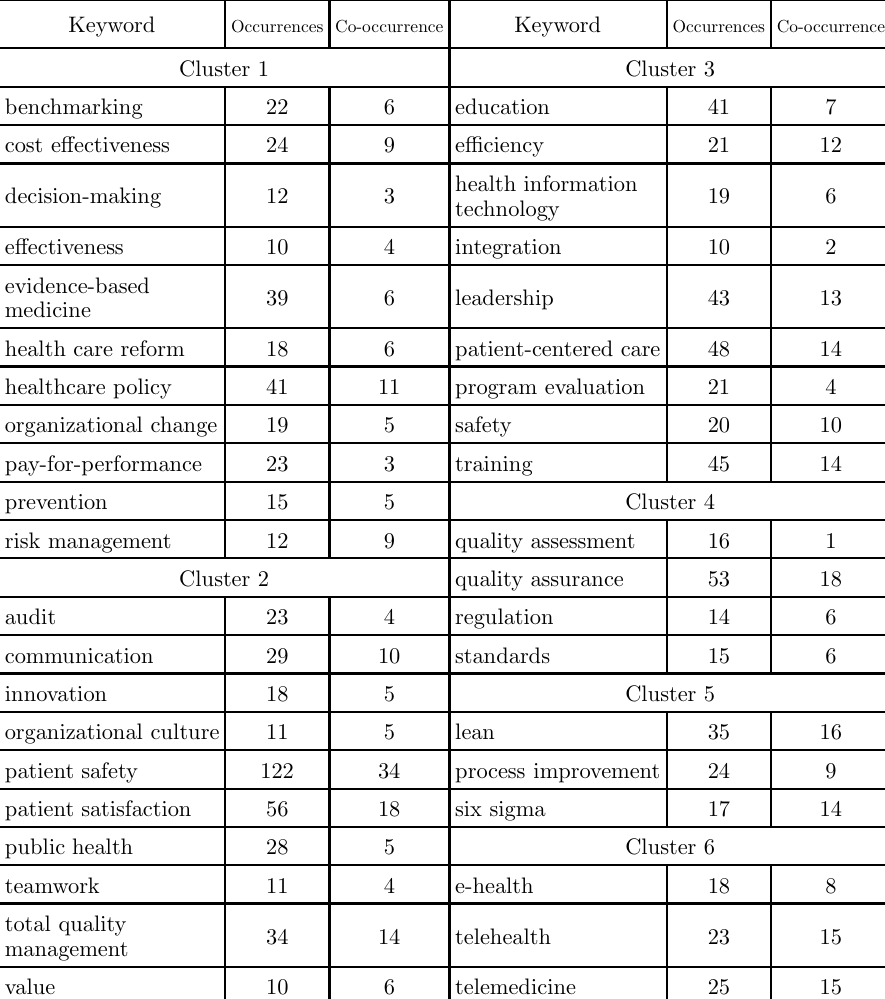
Table 4. Clusters identified through the